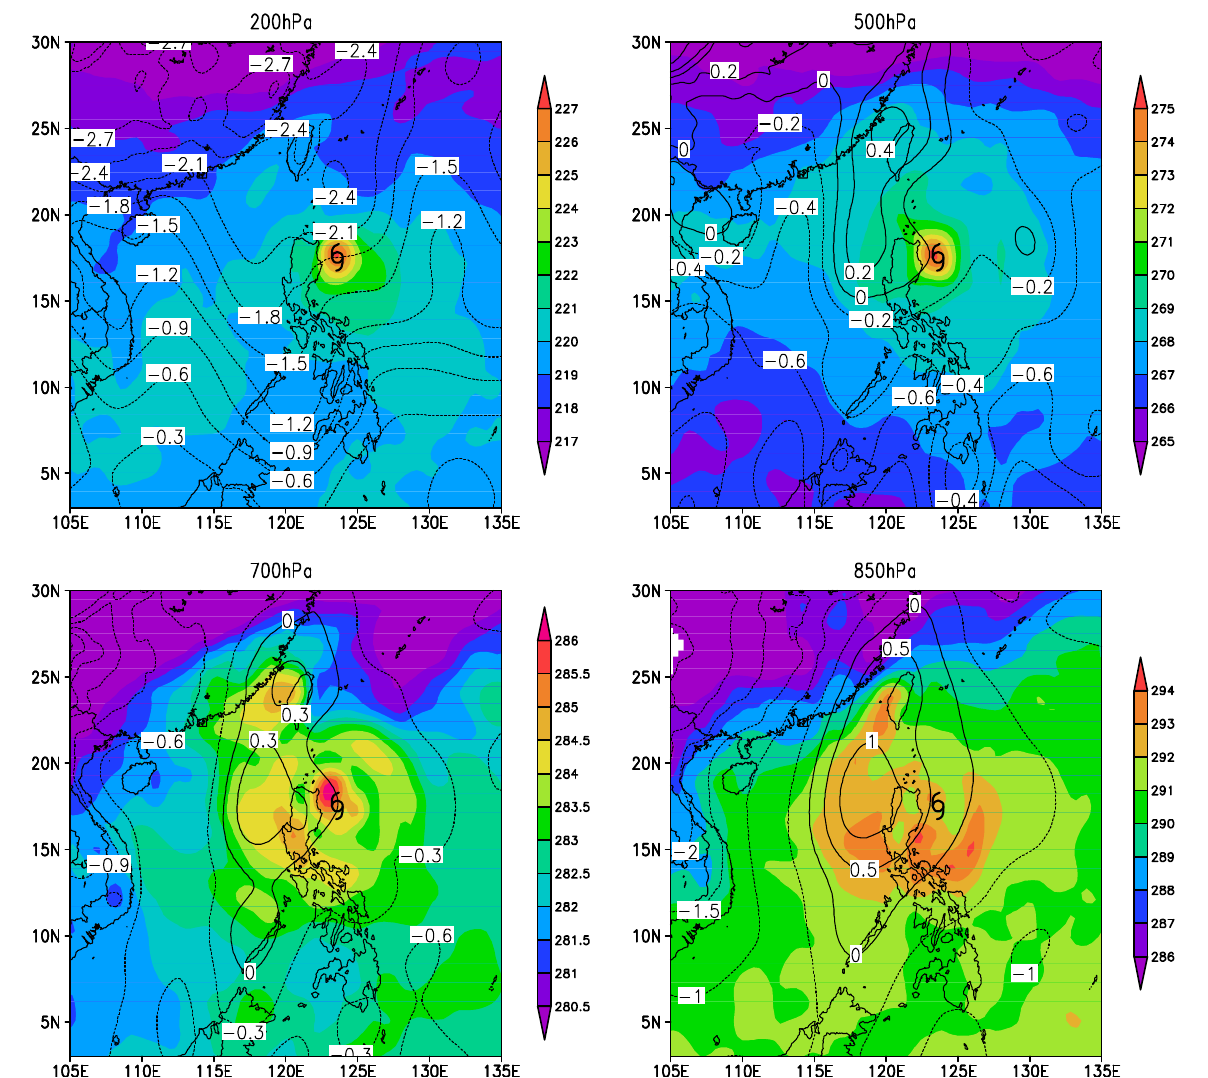
Figure 5. Initial temperature (shaded, unit: K) and temperature increment (RAD ‐ DA minus CTL, contour, unit: K) at 200 hPa, 500 hPa, 700 hPa, and 850 hPa for the RAD ‐ DA experiment.